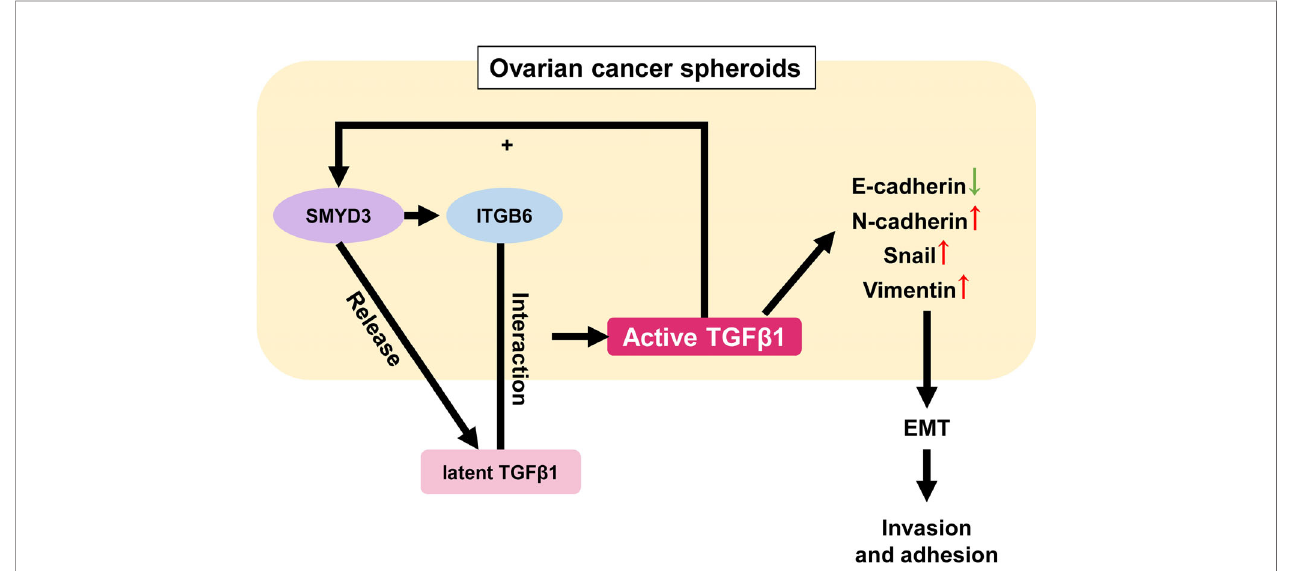
FIGURE 7 | Schematic model of the role of the SMYD3/ITGB6/TGF b 1 positive feedback loop in promoting the invasion and adhesion of ovarian cancer spheroids. In ovarian cancer spheroids, SMYD3 can increase the expression of ITGB6. When latent TGF b 1 binds to ITGB6 on the cell surface, TGF b 1 is activated and upregulates the expression of N-cadherin, Snail, Vimentin as well as downregulates E-cadherin to enhance the invasion and adhesion of ovarian cancer spheroids by stimulating the Smad3 pathway. Ovarian cancer spheroids can release more latent TGF b 1 at the same time. In addition, TGF b 1 can also facilitate the expression of SMYD3 and ITGB6 in a feedback